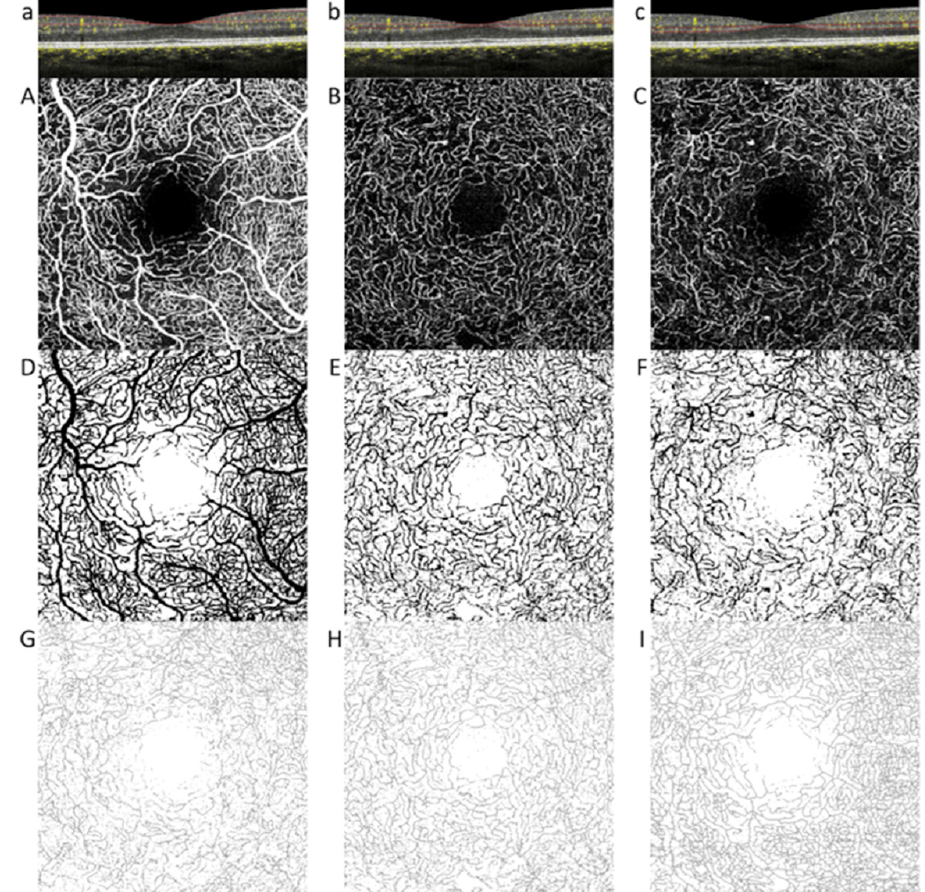
Figure 2. En-face optical coherence tomography (OCT) angiography of the superficial vascular plexus (SVP), intermediate (ICP) and deep capillary plexus (DCP) with the corresponding slabs at the OCT B scan ( a – c ). The SVP ( A ) en-face image was generated by a slab extending from RNFL to inner plexiform layer (IPL)-(IPL-corresponds to 17 µ m over IPL), the ICP ( B ) by a slab extending from IPL − to IPL + (IPL + corresponds to 22 µ m below IPL) and the DCP ( C ) by a slab extending from IPL + to outer plexiform layer (OPL). Automatically binarized ( D – F ) and skeletonized ( G – I ) images of each plexus with ImageJ software.